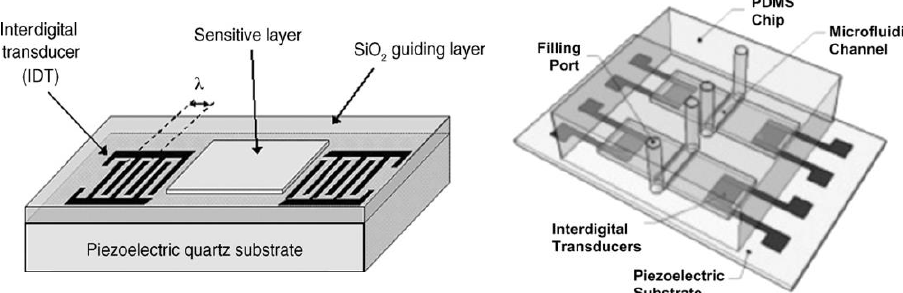
Figure 18. Love-wave sensing platform with PDMS microchannels for biosensing [167].